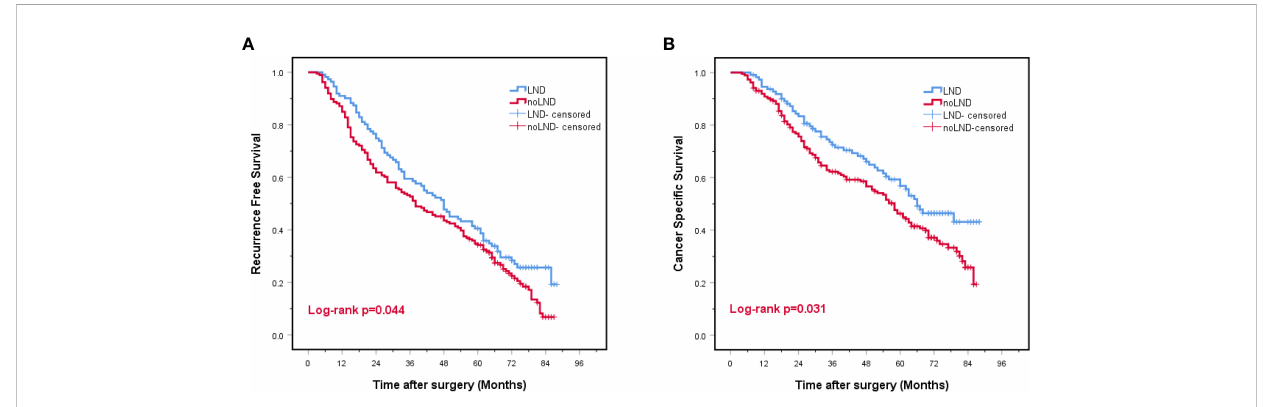
FIGURE 2 Kaplan-Meier curves for recurrence-free survival (A) and cancer-speci fi c survival (B) for the entire study cohort. LND, lymph node dissection, Red font means P value <